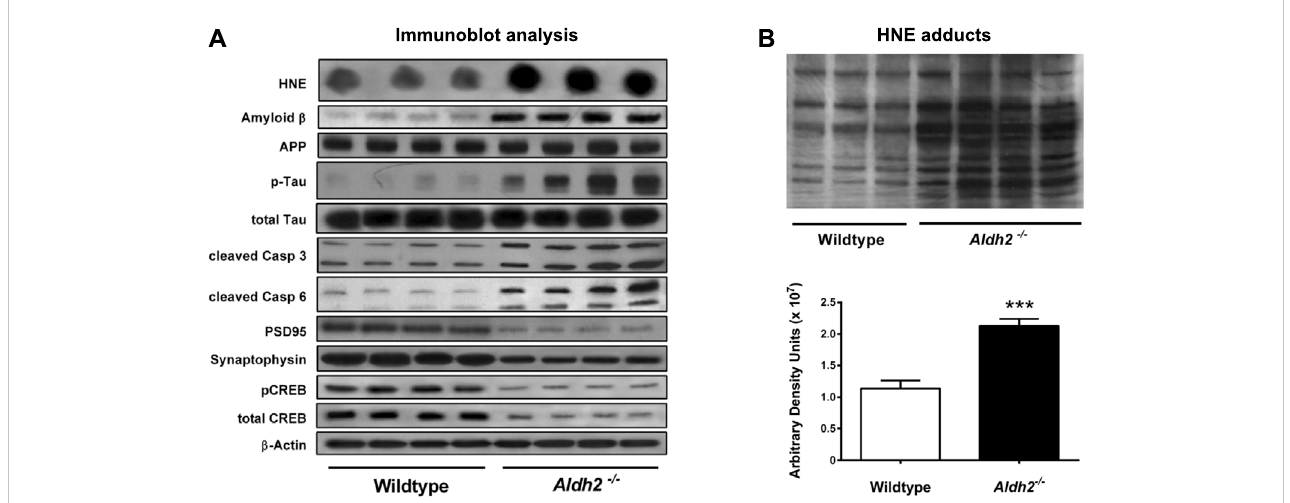
Molecular markers and hydroxynonenal (HNE) adducts in the hippocampus of Aldh2 − / − mice. Panel (A) Immunoblot analysis of hippocampal homogenates from wildtype or Aldh2 − / − mice. Aldh2 − / − mice showed increase of Alzheimer ’ s disease-associated markers (top part) and decrease in synaptic markers (bottom part), compared to the wildtype. Panel (B) Aldh2 − / − mice showed a signi fi cant increase of HNE adducts, compared to the wildtype. APP, amyloid precursor protein; P-tau, hyperphosphorylated tau protein; Casp, caspase; PSD95, postsynaptic density protein 95; CREB, cyclic AMP response element binding protein. Reprinted with permission from D ’ Souza et al. (2015).